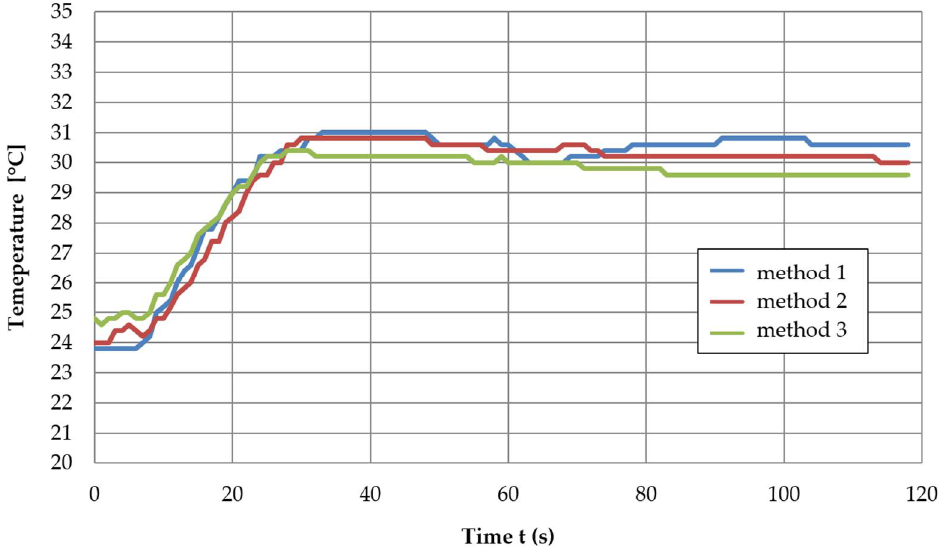
Figure 10. Comparison of control methods for the water heating condition in terms of average temperature in time.